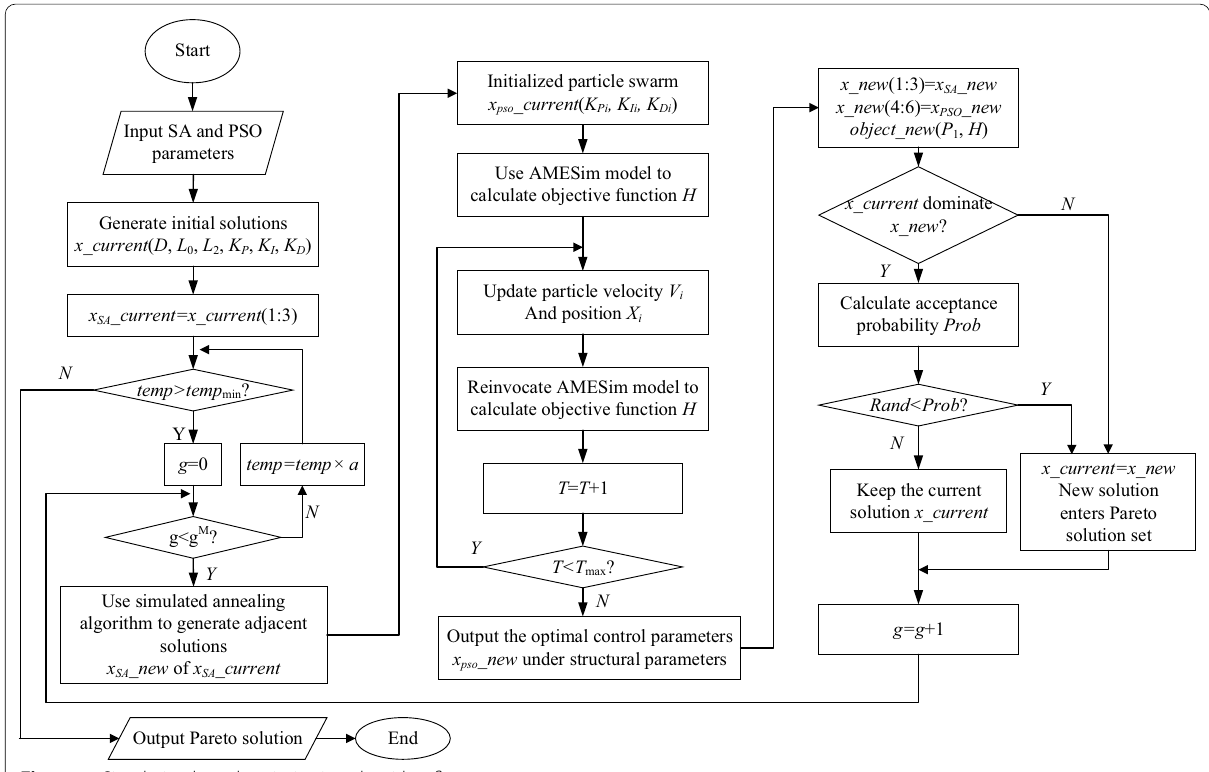
Figure 7 Simulation based optimization algorithm